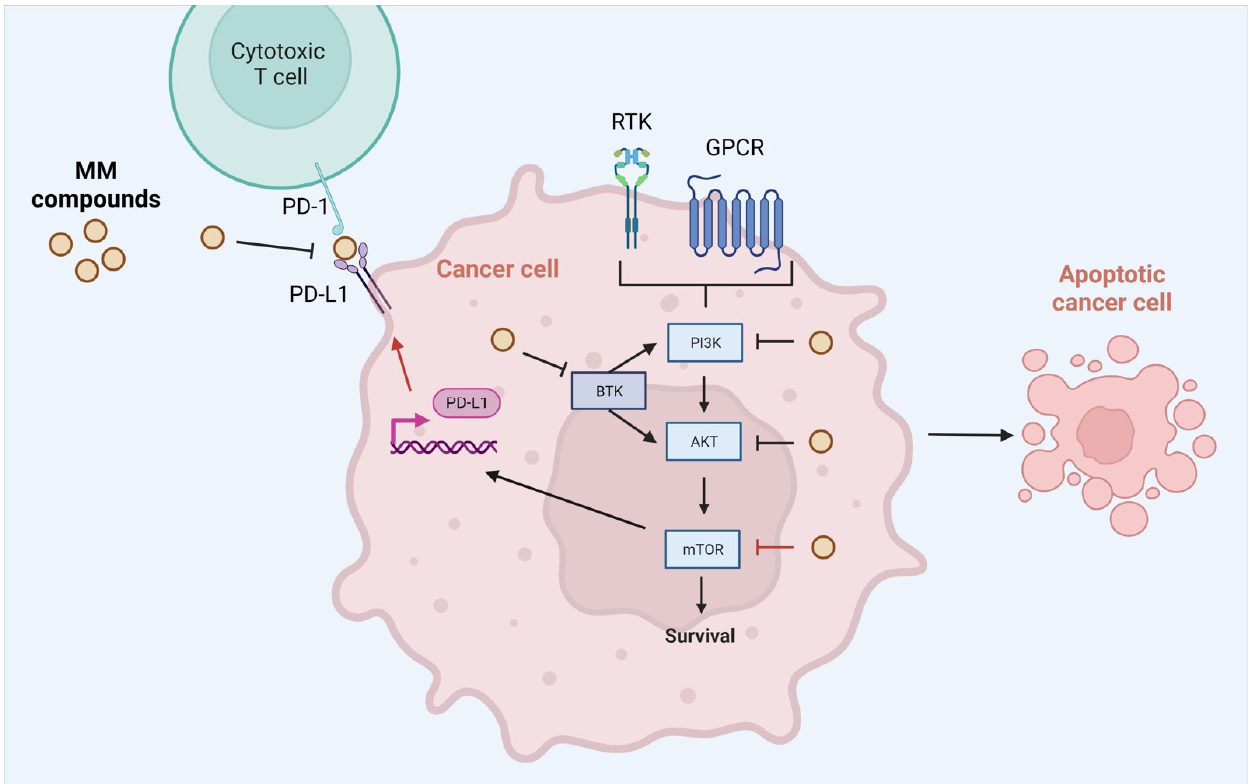
Figure 14. Probable mechanism of action of Pyrazolo[4,3- e ]Tetrazolo[4,5- b ][1,2,4]Triazine sulphon- amides (MM-compounds). Abbreviations: AKT—protein kinase B BTK—Bruton’s tyrosine kinase; sulphonamides (MM-compounds). Abbreviations: AKT—protein kinase B BTK—Bruton’s tyro- JAK—tyrosine-protein kinase JAK; mTOR—mammalian target of rapamycin; PI3K—phosphoinosi- sine kinase; JAK—tyrosine-protein kinase JAK; mTOR—mammalian target of rapamycin; PI3K— tide 3-kinases; PD-1—Programmed cell death protein 1; PD-L1—Programmed death-ligand 1. Cre- phosphoinositide 3-kinases; PD-1—Programmed cell death protein 1; PD-L1—Programmed